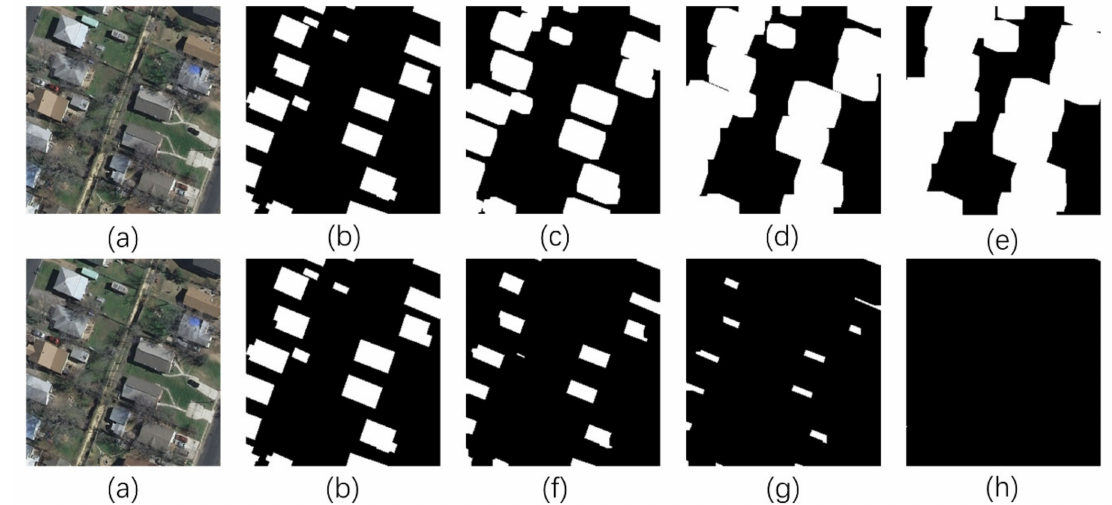
Figure 2. The erroneous-sample generation with the expansion and erosion processing. The first row is expansion results that represent ( a ) the image, ( b ) the ground-truth, ( c ) a redundant label with kernel size 9, ( d ) a redundant label processed by kernel size 17, and ( e ) the inc label processed by kernel size 25. The erosion processing is showing in the second row: ( f ) insufficient label with kernel 9, ( g ) insufficient label by kernel 17, and ( h ) missed label processed by kernel size 25.